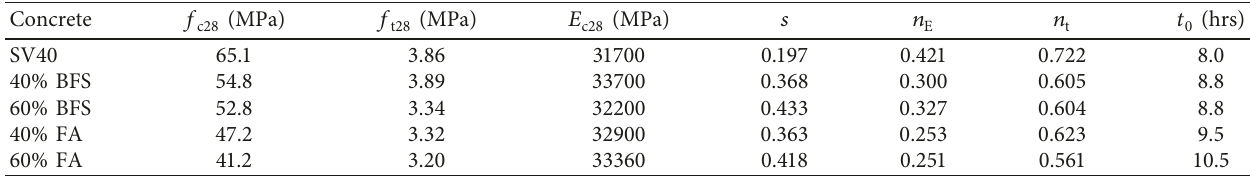
Table 3: Model parameters for mechanical properties.